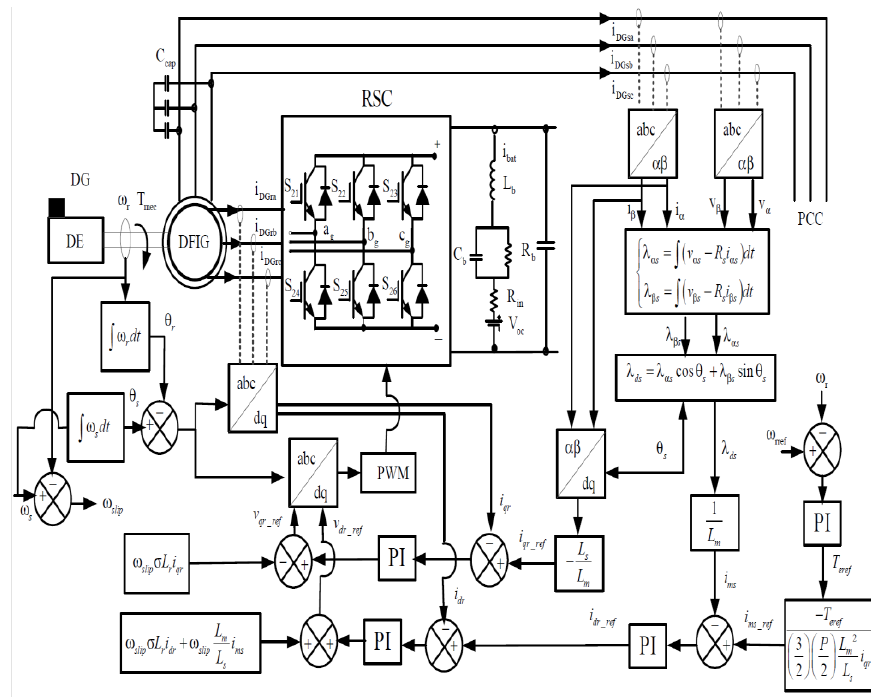
Figure 18. Indirect stator flux-oriented control for rotor side converter [140].